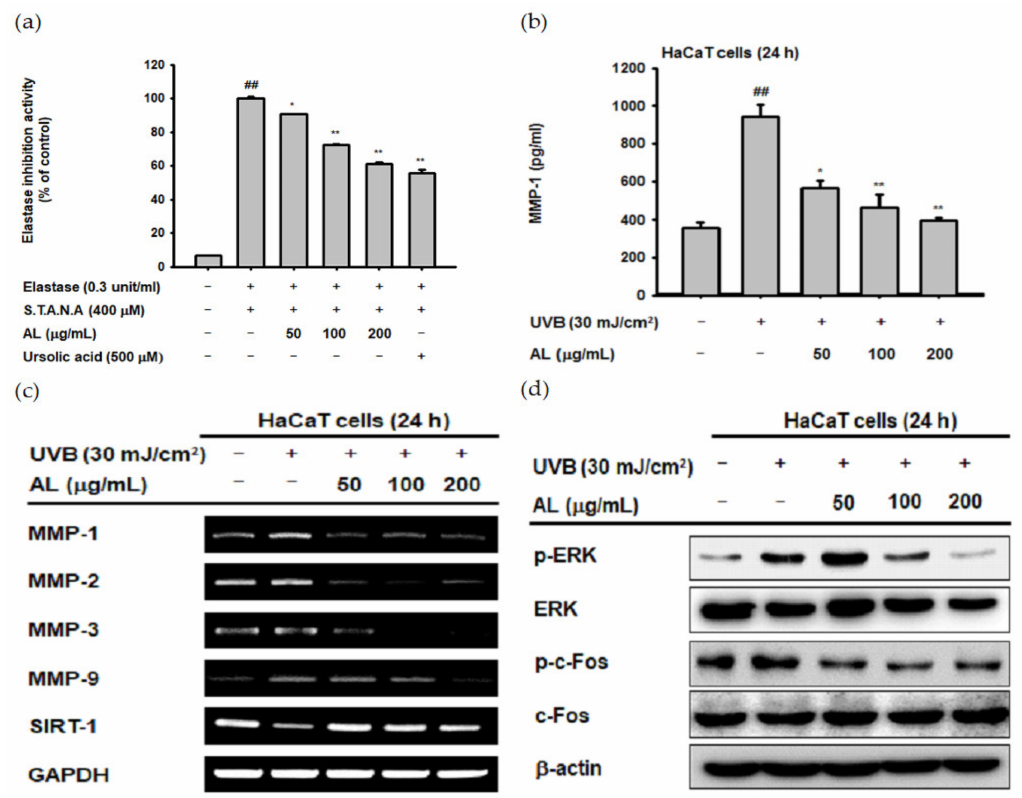
Figure 2. Antiwrinkle e ff ects of AL due to activation of the activator protein 1 (AP-1) signaling pathway in HaCaT cells. ( a ) Following pretreatment with AL (50–200 µ g / mL), HaCaT cells were incubated with elastase (0.3 unit / mL) and STANA (400 µ M), and the elastase inhibition was measured. ( b ) The expression of matrix metalloproteinases (MMP-1) in HaCaT cells treated with AL (50–200 µ g /